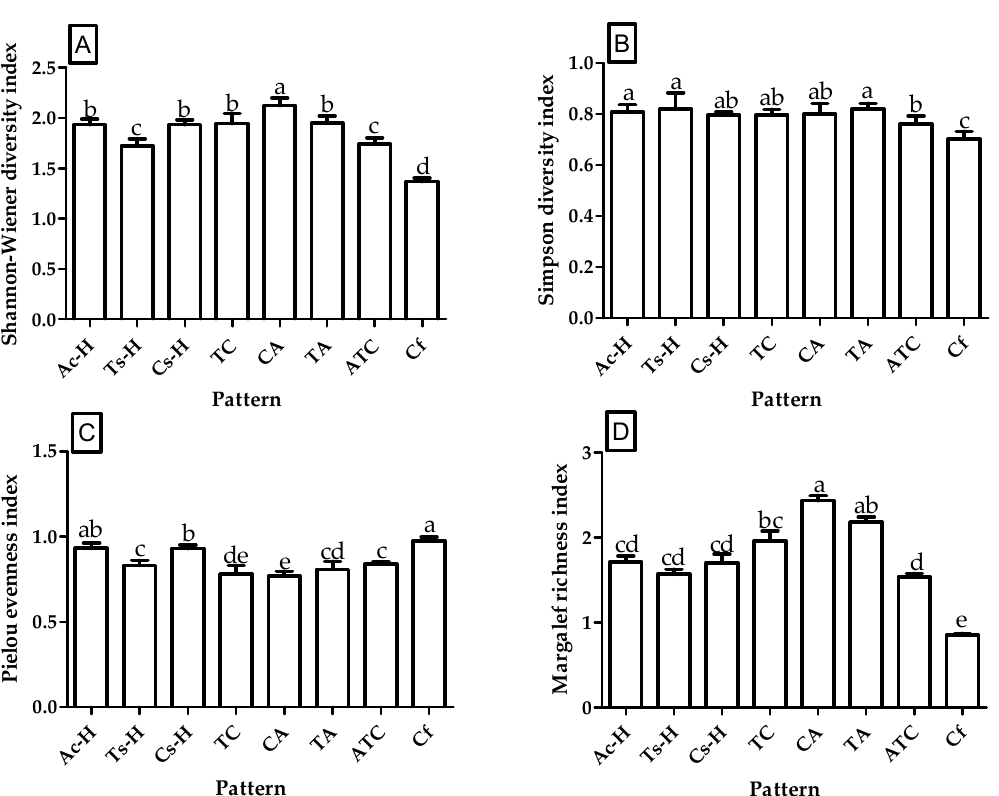
Figure 3. The diversity of shrubs among the different tree species component reconstruction patterns of low-efficiency stands of Cupressus funebris . The ( A ) Shannon–Wiener diversity, ( B ) Simpson diversity, ( C ) Pielou evenness, and ( D ) Margalef richness indices of shrubs under different reconstruction patterns were investigated. Each bar denotes three replicates ( ± SD). Different letters indicate significant differences among different reconstruction patterns compared by Fisher’s least significant differences (LSD) test at p < 0.05. Ac-H: high-density Alnus cremastogyne ; Ts-H: high-density Toona sinensis ; Cs-H: high-density Cinnamomum septentrionale ; TC: Ts + Cs; CA: Cs + Ac; TA: Ts + Ac; ATC: Ac + Ts+ Cs; CB: cutting-blank; Cf: Cupressus funebris. High density: 1.5 m × 2 m; low density: 1.5 m × 4